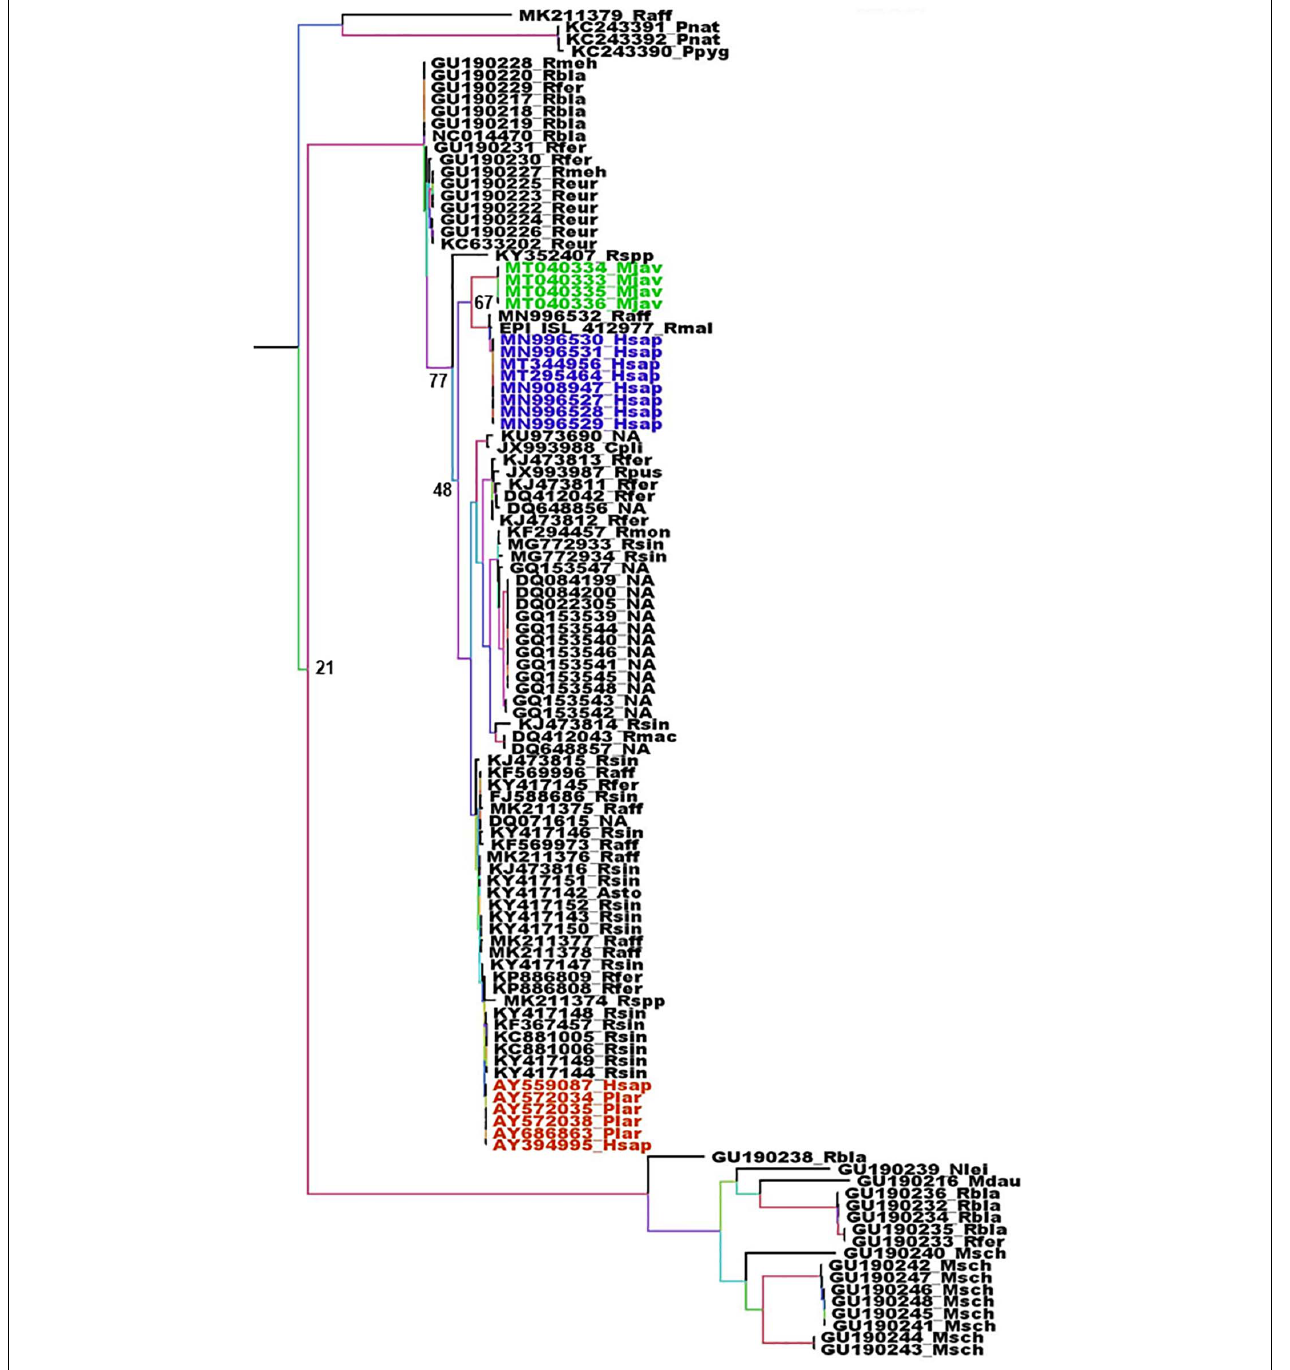
FIGURE 3 | Phylogenetic analysis of Sarbecoviruses RdRp genes. The alignment of the full RdRp genes was performed with MUSCLE from the SeaView package (Gouy et al., 2010). The tree was built using the maximum likelihood method under the GTR model with 500 repeats. The tree was rooted using the RdRp sequence of a MERS-CoV from Camelus dromedarius (KT368883) as outgroup. Violet: RdRp sequences from human SARS-CoV-2. Green: RdRp sequences from pangolins’ Sarbecoviruses. Red: RdRp sequences from SARS-CoV. Sample names are built with the GenBank accession number followed by a four-letter code identifying the species. The species codes are as follows: Asto, Aselliscus stoliczkanus ; Cpli, Chaerephon plicata ; Hsap, Homo sapiens ; Mdau, Myotis daubentonii ; Mjav, Manis javanica ; Msch, Miniopterus schreibersii ; Nlei, Nyctalus leisleri ; Plar, Paguma larvata; Pnat, Pipistrellus nathusii ; Ppyg, Pipistrellus pygmaeus ; Raff, Rhinolophus affinis ; Rbla, Rhinolophus blasii ; Reur, Rhinolophus euryale ; Rfer, Rhinolophus ferrumequinum ; Rmac, Rhinophilus maculatus ; Rmal, Rhinolophus malayanus ; Rmeh, Rhinolophus mehelyi ; Rmon, Rhinophilus monoceros ; Rpus, Rhinolophus pusillus ; Rsin, Rhinolophus sinensis ; Rspp, Rhinolophus unidentified species; NA, Not